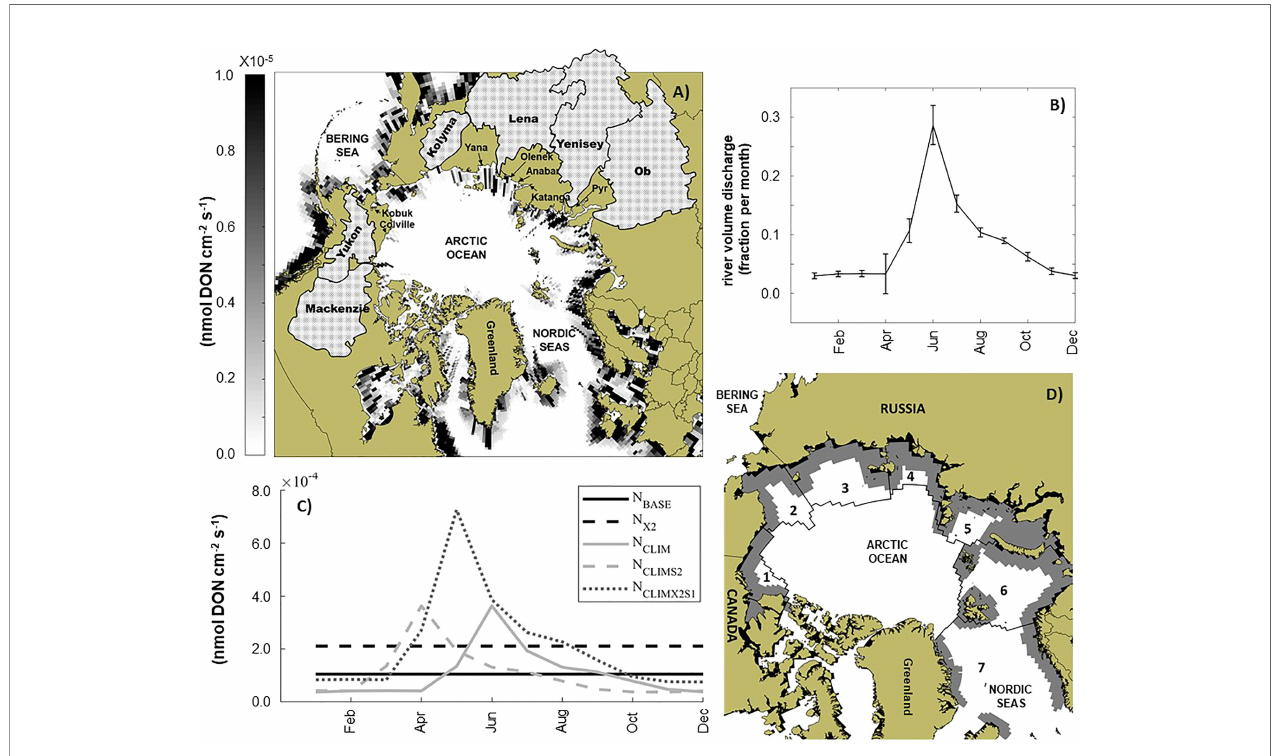
FIGURE 1 | Study area, example river inputs, and analysis regions. (A) Spatially varying river input from dissolved organic nitrogen (nmol cm -2 s -1 ) for September 1948. To help orientate the reader, the approximate location of major rivers around the Arctic Ocean, along with the watersheds of the six largest rivers (hatched area), the Bering Sea, Kara Sea, and Nordic Seas are indicated. (B) Scaled monthly average volume discharge (S m ) for all rivers north of 66.5°N). (C) Example time series of baseline constant river nutrient input (N BASE ), doubled constant river nutrient input (N X2 ), monthly climatology of river nutrient inputs (N CLIM ) derived by scalling N BASE by S m, climatology of river nutrient inputs shifted by two months (N CLIMS2 ), and climatology of river nutrients doubled and shifted by one month (N CLIMX2S1 ): These examples of annual river nutrient inputs are for location 74.2°N,77.1°E in the Kara Sea, indicated by the white star symbol in (A) . (D) Map of study area showing the location of the seven regions considered in our analysis. Beaufort Sea (R1), Chukchi Sea (R2), East Siberian Sea (R3), Laptev Sea (R4), Kara Sea (R5), Barents Sea (R6), and the Nordic Seas (R7). The grey shaded region indicates the marine coastal zone within each region, which was assumed to be three ocean grid cells from